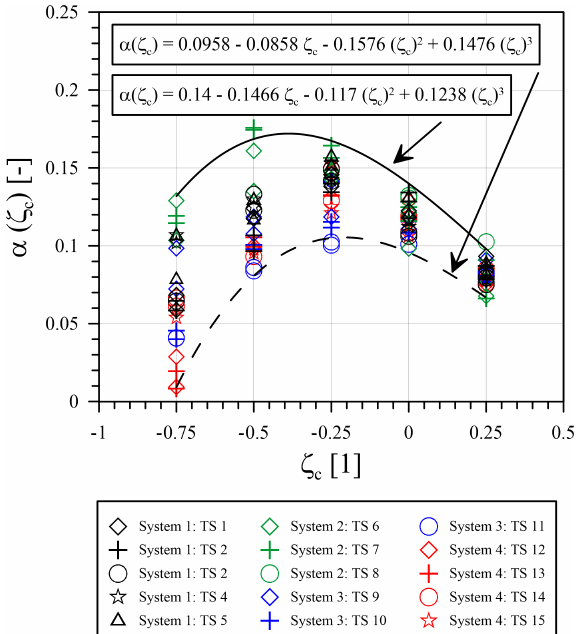
Figure 8. Evaluation of cyclic test results: relationship between accumulation parameter ( α ) with cyclic load ratio ( ζ c ) and corre- sponding lower and upper bound curves.